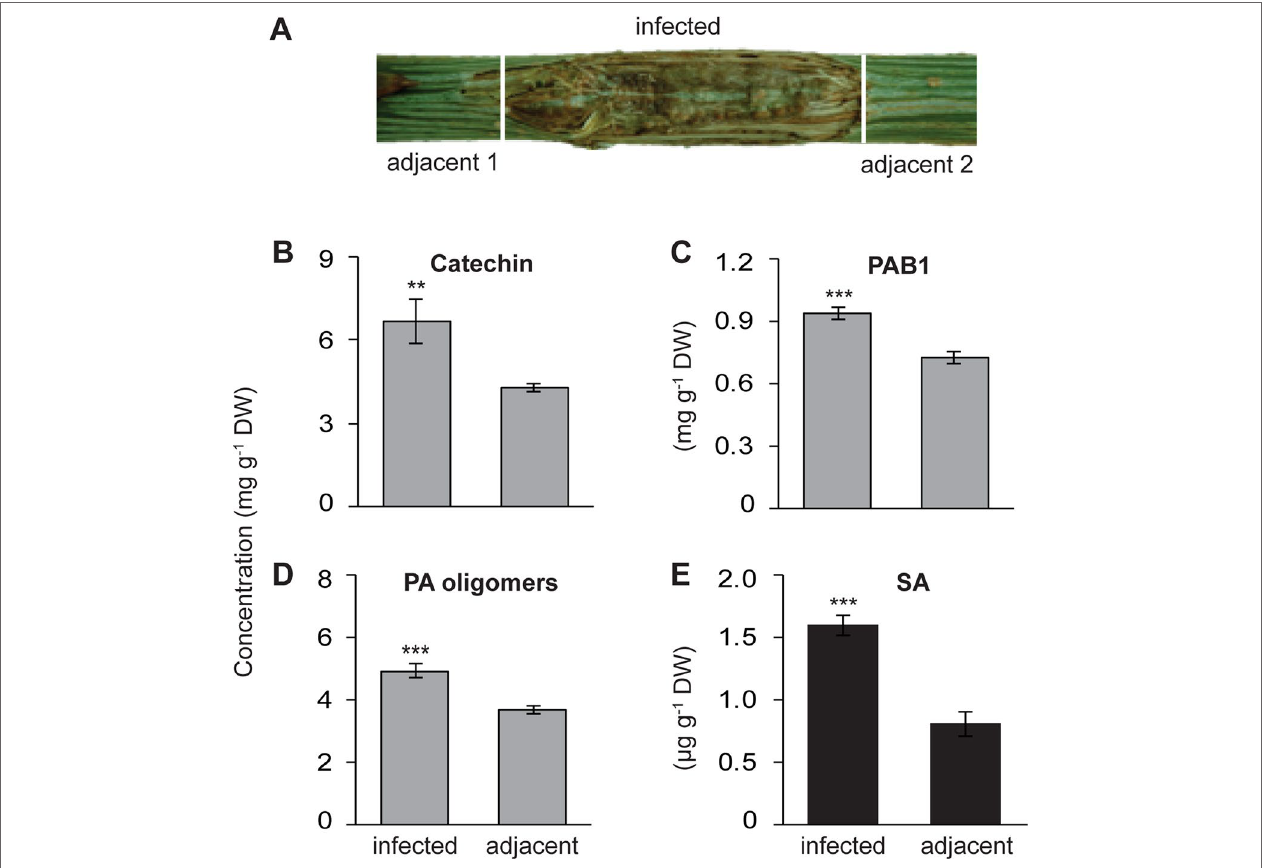
FIgURe 1 | Increased local accumulation of catechin, proanthocyanidins (PAs) and salicylic acid (SA) in the stems of black poplar saplings after infection by P. populi compared to adjacent uninfected stem internodes. Poplar trees of approximately 1 m height were inoculated with the fungus. (A) Representative picture showing a P. populi- infected poplar stem with sampling areas. Infected stem internodes and adjacent uninfected internodes were harvested 6 weeks after inoculation. (B – D) Concentrations of the flavan-3-ol monomer (+)-catechin), the dimer PAB1, and oligomeric PAs. (+)-Catechin and PAB1 were analyzed by LC-tandem mass spectrometry. PA oligomers up to 10 monomeric units were measured by HPLC-FLD. The contents of PAB1 and PA oligomers were equivalent to the content of catechin. (e) Concentration of SA was analyzed by LC-tandem mass spectrometry. Data were analyzed using a paired t-test (**, p < 0.01; and ***, p < 0.001). Bars represent mean ± SE (n = 5). DW, dry weight.